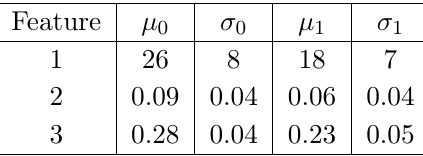
Table 1 . Mean ( (cid:22) ) and standard deviation ( (cid:27) ) values of the normal distributions for class 0 and 1 of each